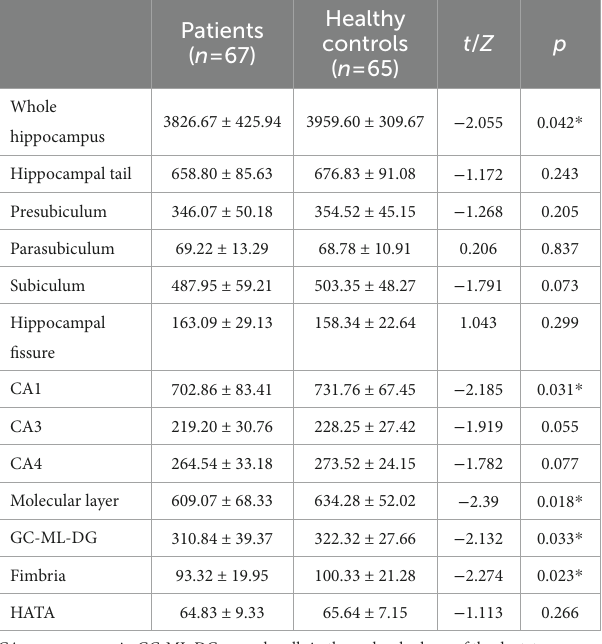
TABLE 1 Demographic and clinical characteristics of participants. Characteristics